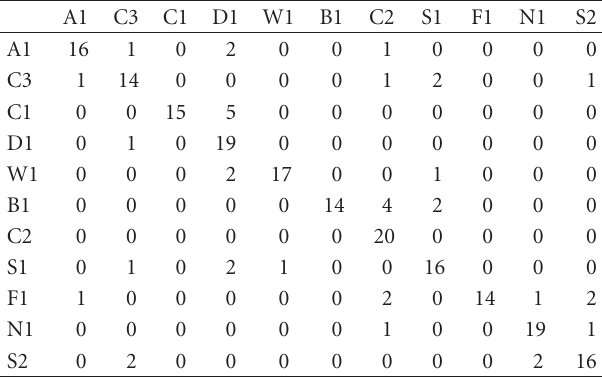
Table 2: Class-confusion matrix for the nearest-neighbor classifi- cation (correlogram).